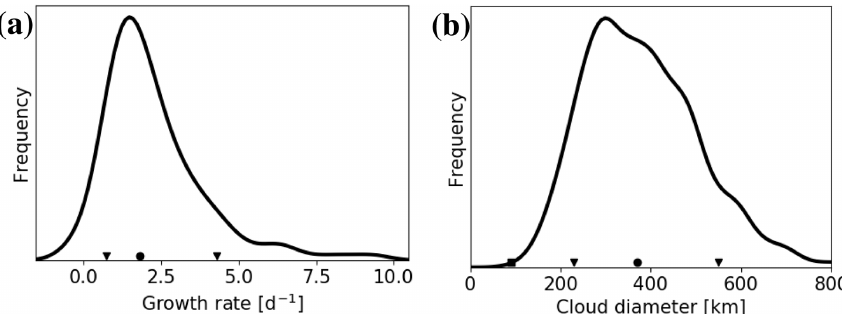
Figure 9. (a) Distribution of the growth-rate maximum during the PL lifetime. (b) Distribution of the cloud diameter for all PL time steps according to Rojo et al. (2019). The dot denotes the median and the triangles the 10th and 90th percentiles of the distributions. The curves are computed with a Gaussian kernel. Table 2. Approximation of values required for the determination of the growth rate, σ max , and the diameter, d σ , of the fastest-growing mode by dry-baroclinic theory. For PLs, the static stability, N , is obtained from Fig. 5, the shear strength, level, H , from Fig. 8. The Coriolis parameter, f , is computed for 70 and 45 ◦ latitude for PLs and mid-latitude cyclones, respectively. For (cid:12) (cid:12) (cid:49) u (cid:12) (cid:12) H are approximated with the use of values from Figs. 2b, 3h and 3i, respectively, of Stoll et al. (2018). mid-latitude cyclones N , (cid:12) and (cid:12) (cid:49)z (cid:12) (cid:12) − 1 ) H (m) f (s − 1 (cid:49) u (cid:12) (cid:12) N (s − 1 ) (cid:12) (cid:12) (s (cid:49)z